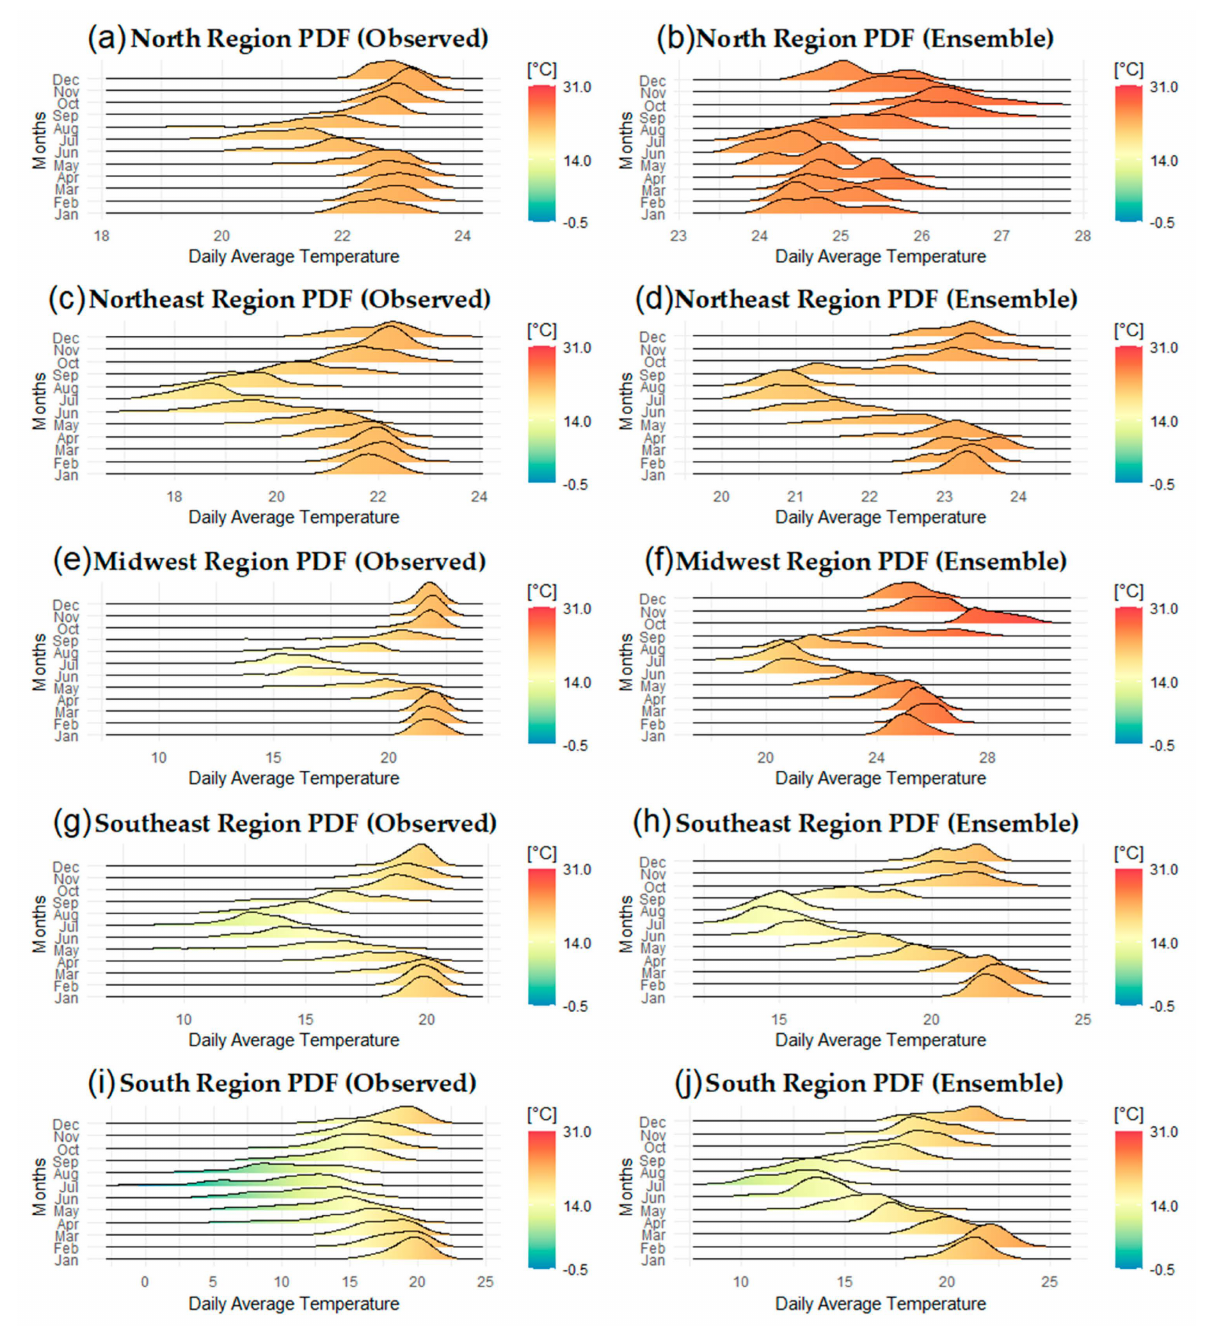
Figure 12. Minimum temperature probability density ( ◦ C), with observed data on the left and BAM data on the right, for each Brazilian region: NO ( a , b ), NE ( c , d ), CO ( e , f ), SE ( g , h ), and S ( i , j